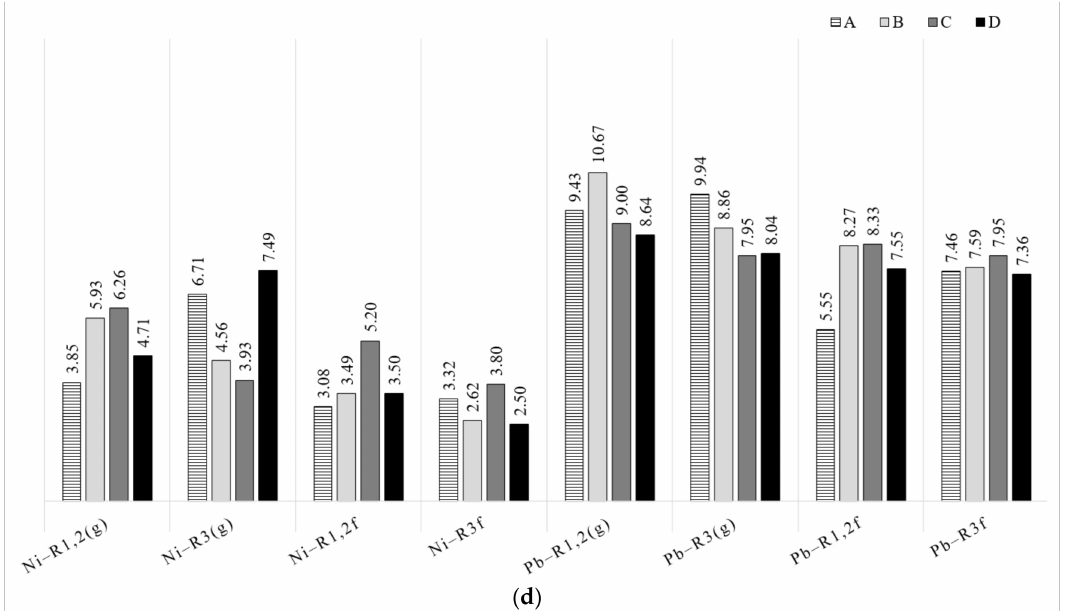
Figure 5. Subtotal content of selected heavy metals in the substrates and in the soil (in mg · kg − 1 d.m.);